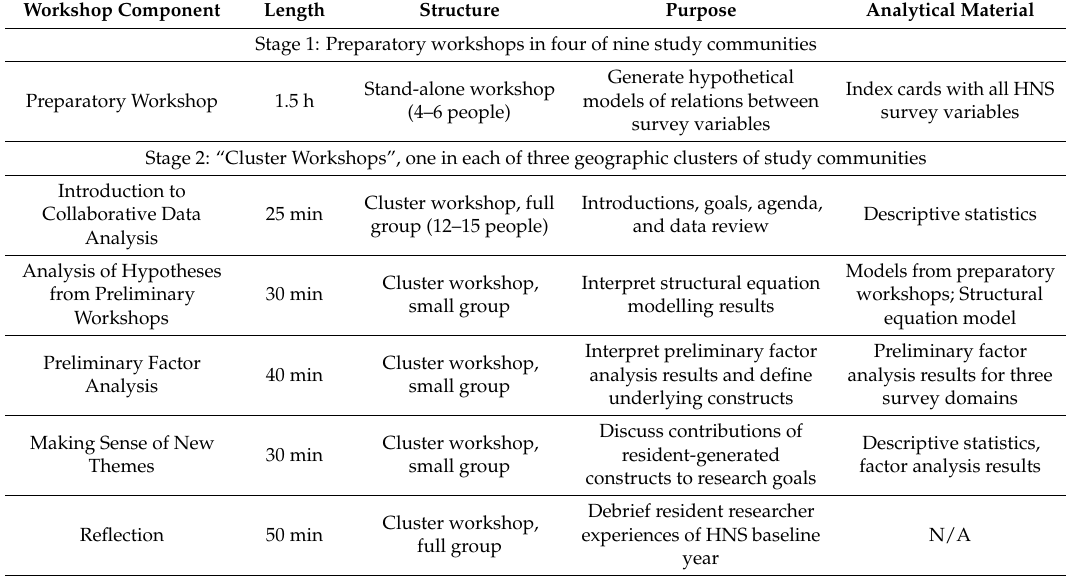
Table 3. Collaborative data analysis workshops,